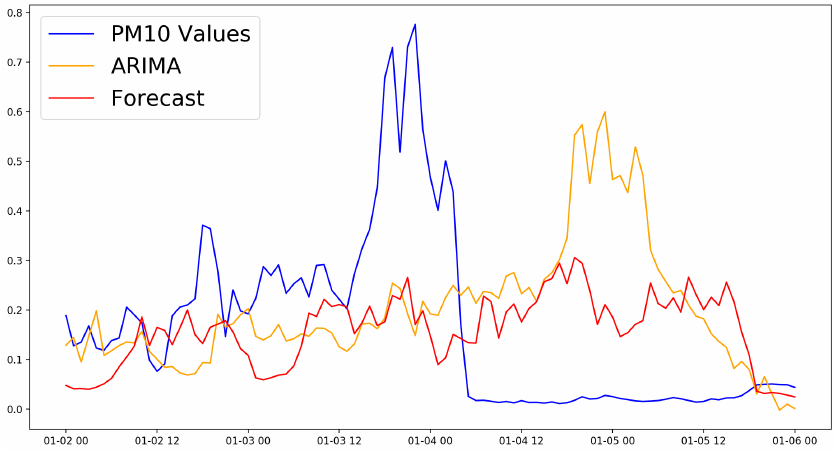
Figure 7. Performance comparison to the ARIMA model of the LSTM + Dense model with the best forecasting performance with the 24 h time horizon in the first week of the test data